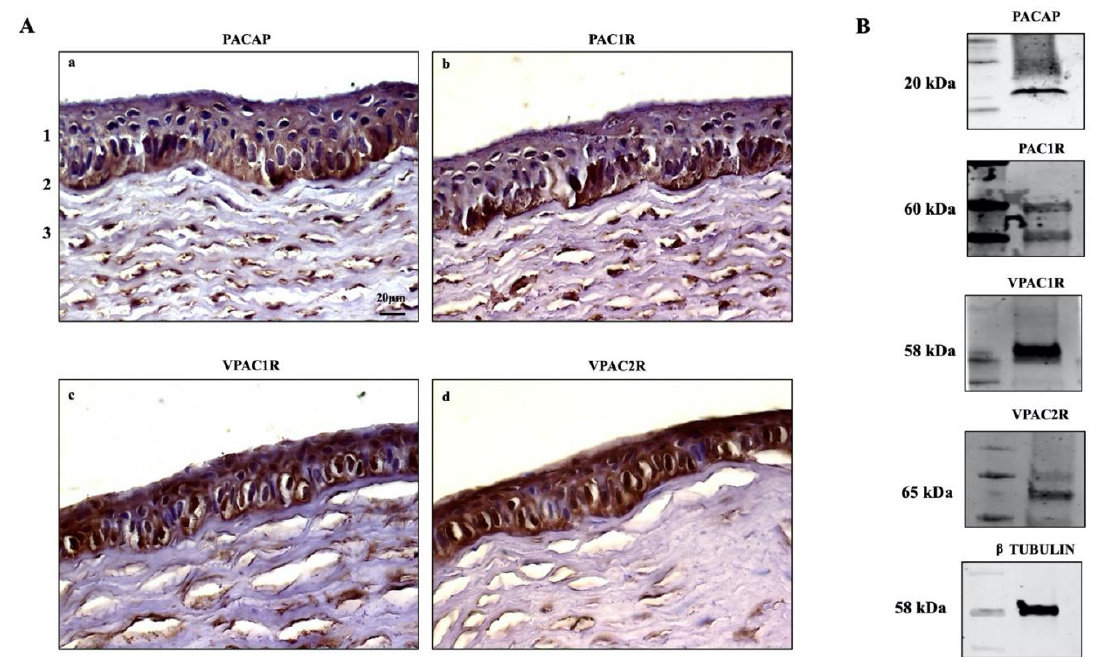
Figure 1. ( A ) Immunodetection of PACAP ( a ), PAC1R ( b ), VPAC1R ( c ), and VPAC2R ( d ) in rabbit cornea: (1) epithelium, (2) Bowman’s membrane, (3) stroma. Original magnification ×200, scale bar: 20 μm. ( B ) Representative immunoblot of PACAP and its receptors in SIRC cells.